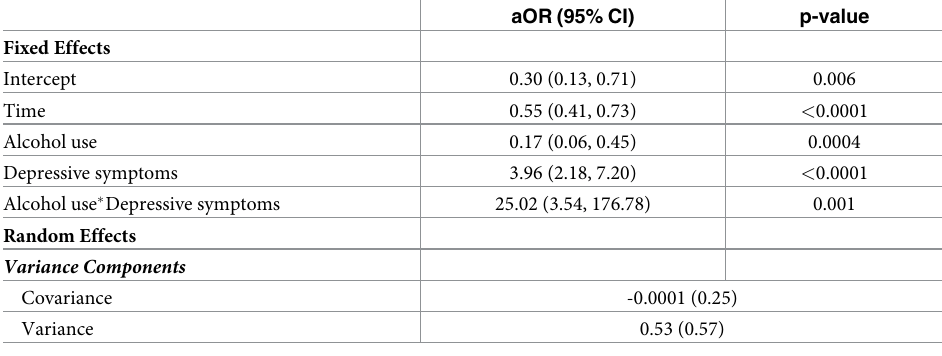
Table 3. Final adjusted conditional growth model a (N = 313).